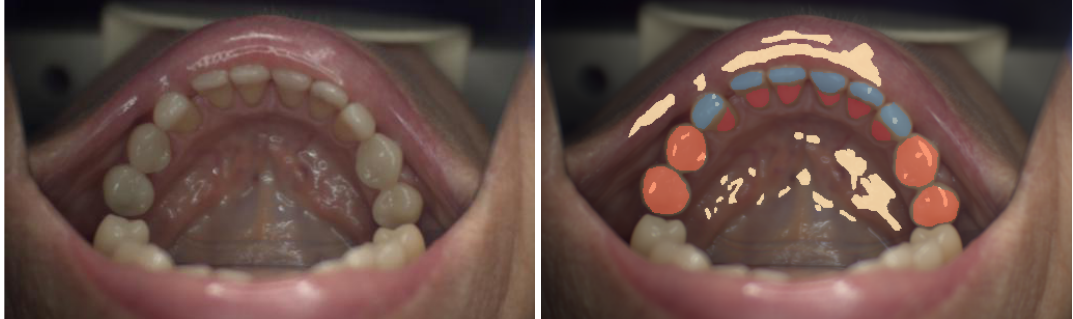
Figure 7. Hard tissue and augmentations labeling example: enamel (red), plastic (blue), prosthetics (orange), and specular reflections